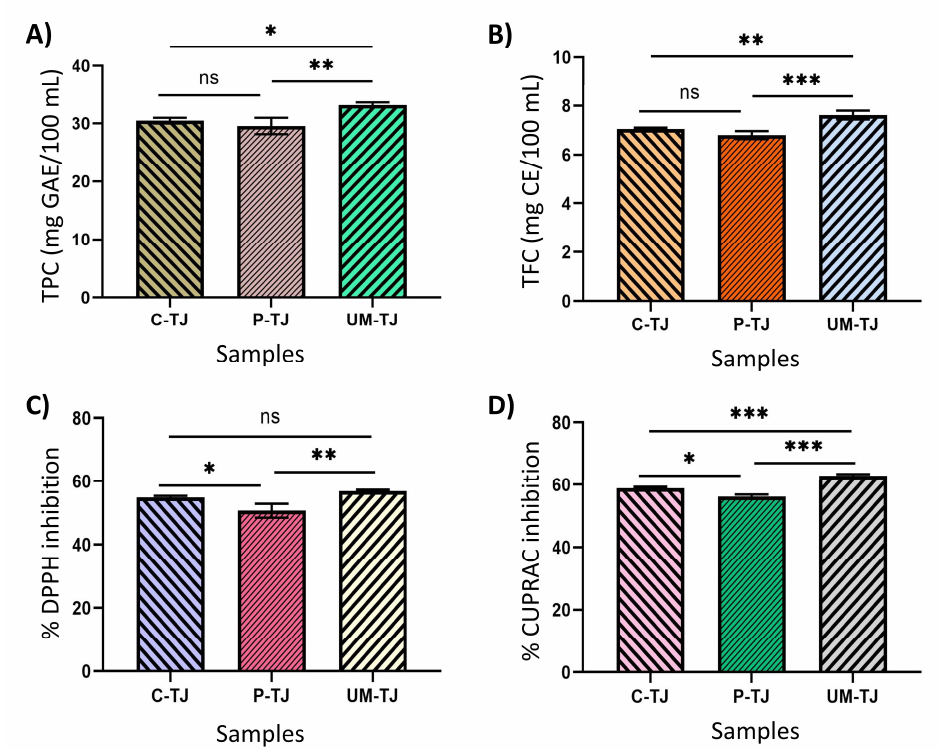
Figure 5. Total phenolic content ( A ), total flavonoid content ( B ), radical scavenging activity ( C ), and cupric reducing antioxidant capacity ( D ) of untreated tangerine juice (C-TJ), thermally pasteurized tangerine juice (P-TJ), ultrasound–microwave-treated tangerine juice (UM-TJ). Characters atop bars indicate statistically significant differences. Analyses were performed with three replicates. (ns: no significant; * p < 0.05; ** p < 0.01), *** p < 0.001).